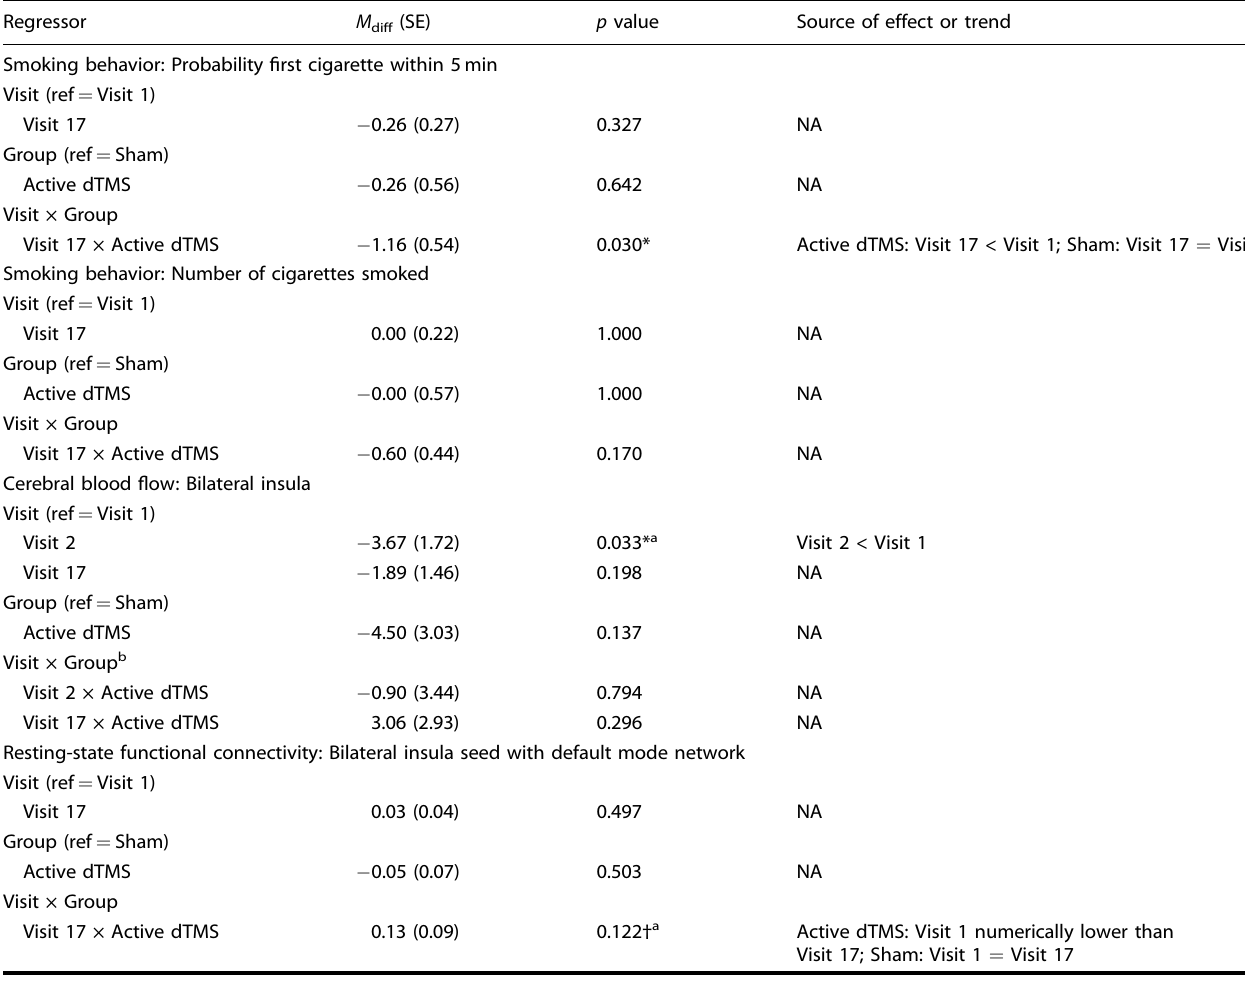
Table 1. Deep rTMS (dTMS) effects on primary variables: Smoking behavior, insula blood fl ow, and insula-centric connectivity. Regressor M diff (SE) p value Source of effect or trend